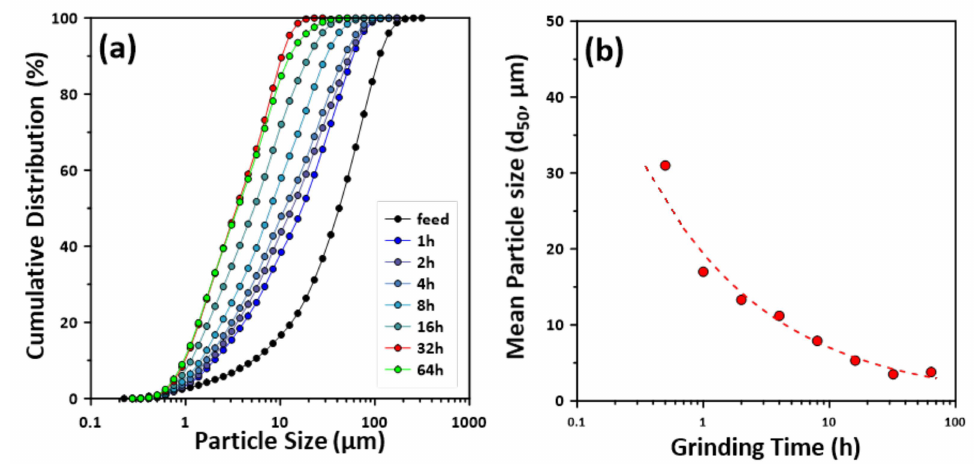
Figure 2. ( a ) Particle size distribution and ( b ) mean particle size of the MSWI ash slag as a function of grinding time. Mean particle size (d 50 ) of the raw acid-treated MSWI ash slag used in this study was 42.5 µ